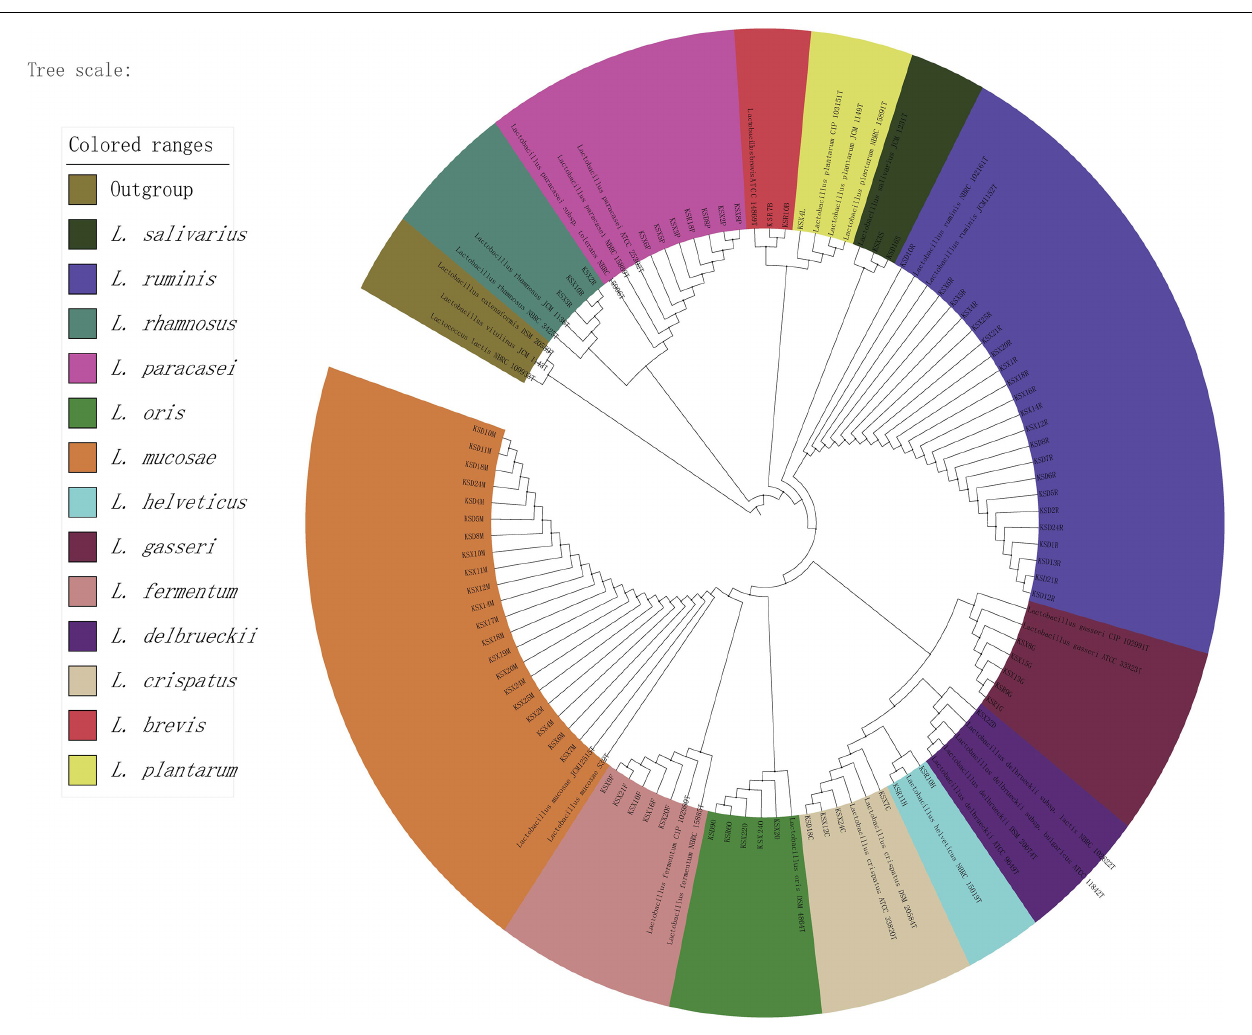
FIGURE 5 | The phylogenetic tree of representative strains of lactobacilli in all samples. The maximum likelihood method was used for the analysis with 1,000 bootstrap repeats.